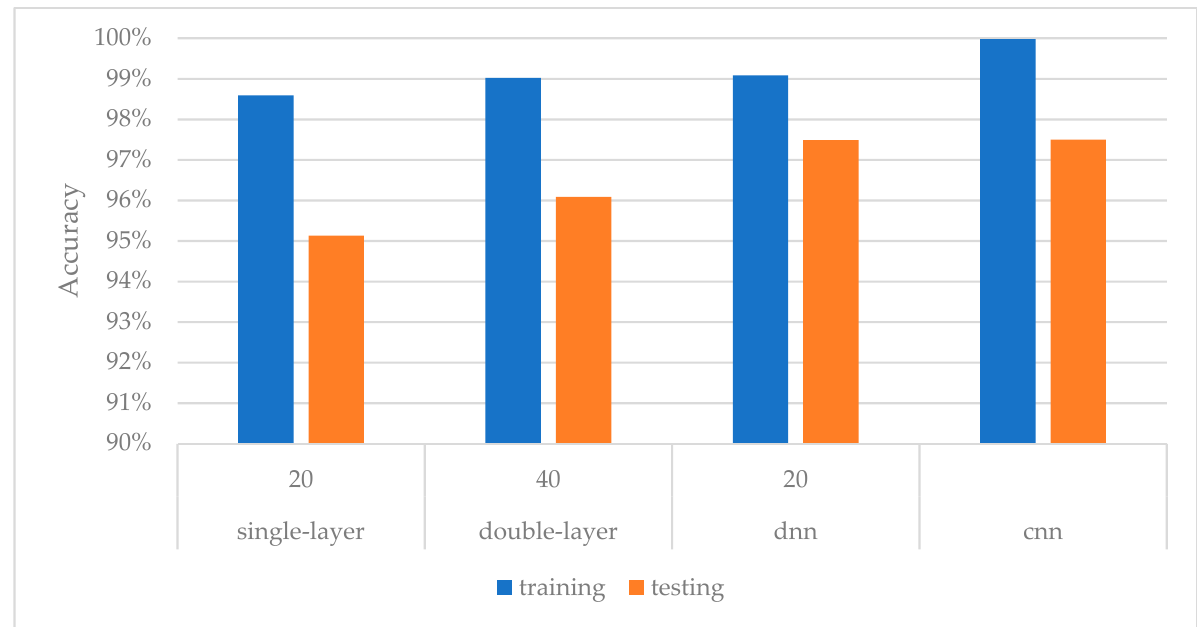
Figure 5. Feature extraction comparison among the four major NN methods.